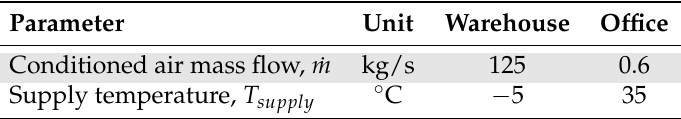
Table 3. Mechanical cooling/heating system characteristics.